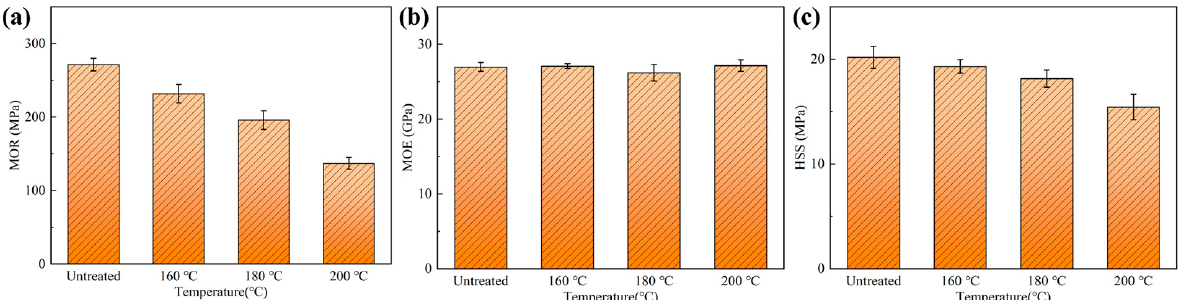
Figure 3. Mechanical properties of bamboo scrimbers after heating at various temperatures: (a) MOR, (b) MOE and (c) HSS.